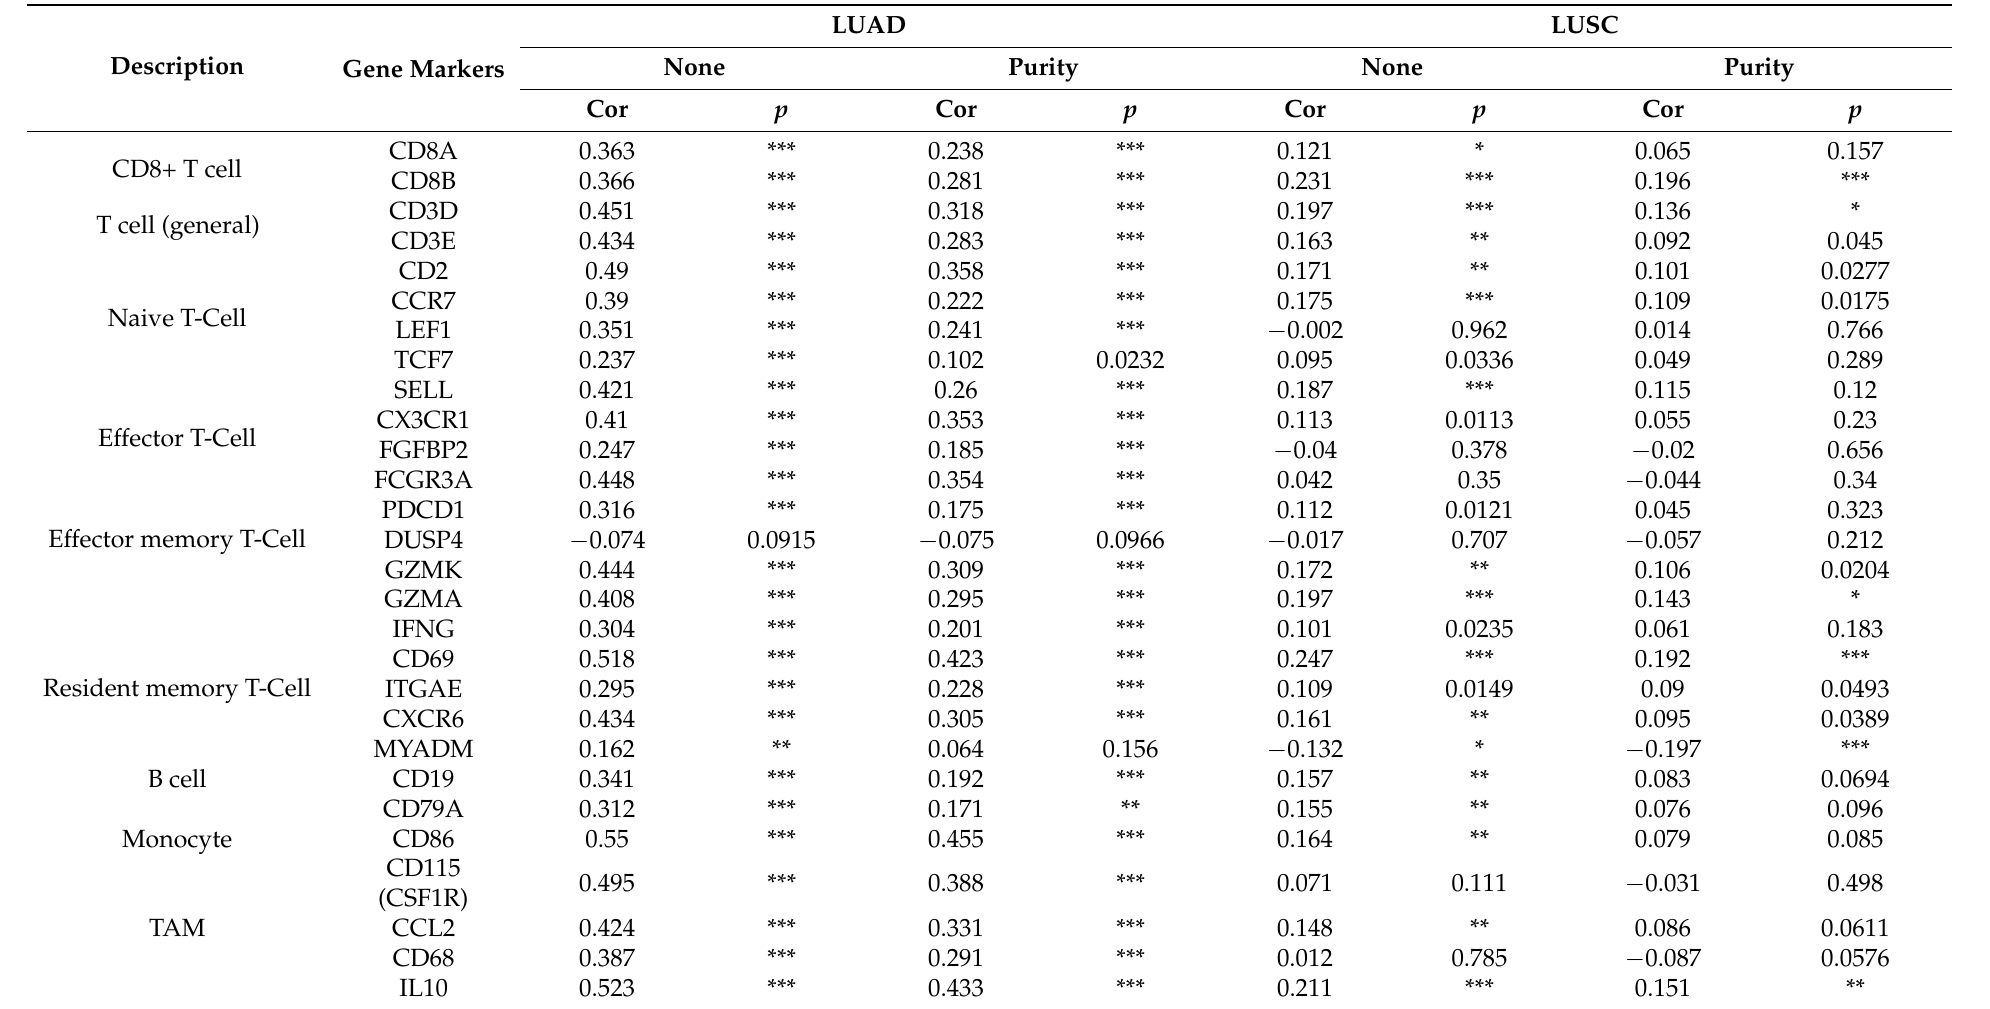
Table 2. Correlation analysis between LPAR6 and relate markers of immune